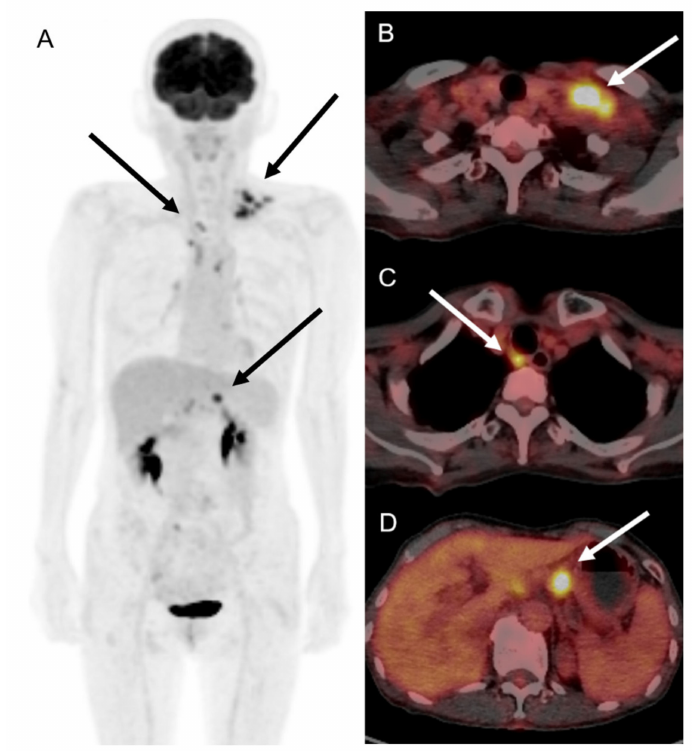
Figure 3. 18 F-FDG PET/CT images of patient with COVID-19 vaccination-induced lymphadenopathy patient. Maximum intensity projection ( A ) and tomographic axial images of 18 F-FDG PET/CT showed multiple hypermetabolism in left supraclavicular ( B ), retrotracheal ( C ), and left gastric artery lymph nodes ( D ), with maximum standardized uptake value of